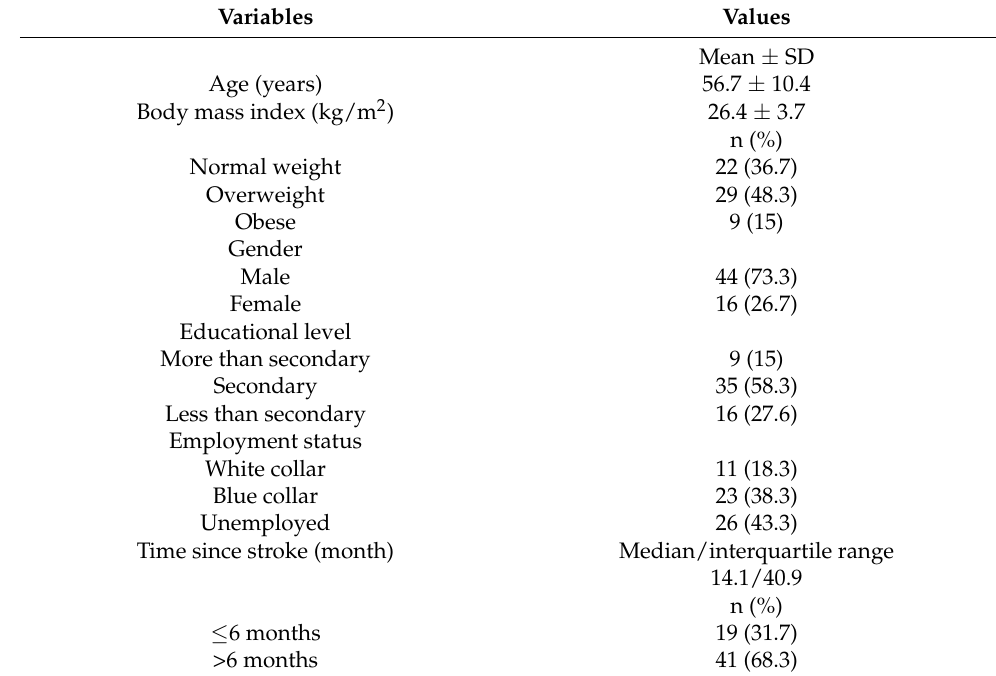
Table 1. Descriptive characteristics of the participants (n =